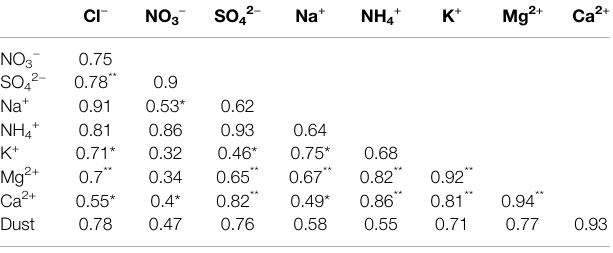
TABLE 3 | Correlations between ion and dust concentrations in snow pits at Yushugou Glacier No. 6 (Person correlation coef fi cient). Cl